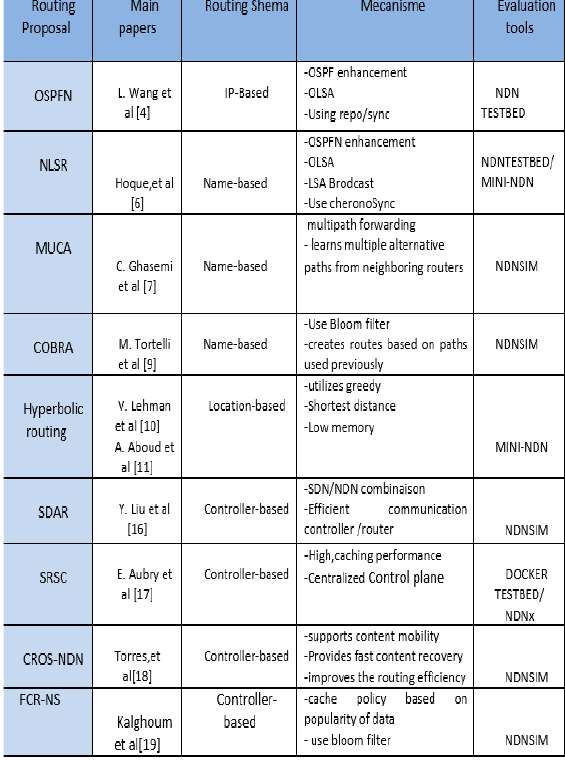
Table. 1. Classification of ndn routing